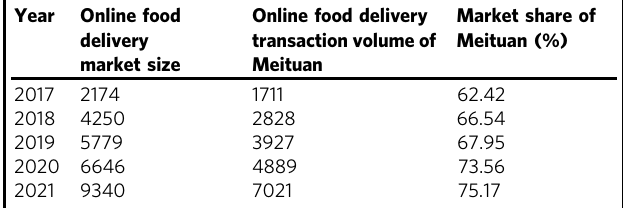
Table 8 Online food delivery market size in China, and online food delivery transaction volume and market share of Meituan (100 million yuan,